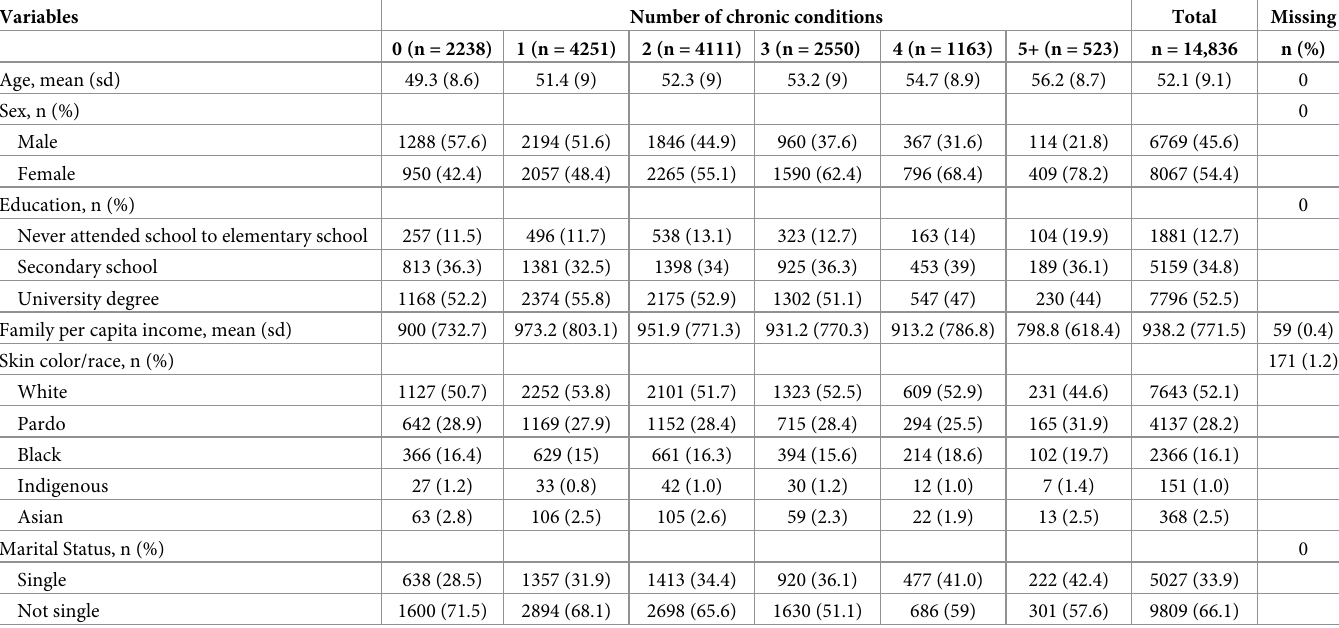
Table 1. Sociodemographic characteristics for the study population, according to the number of chronic conditions. Variables Number of chronic